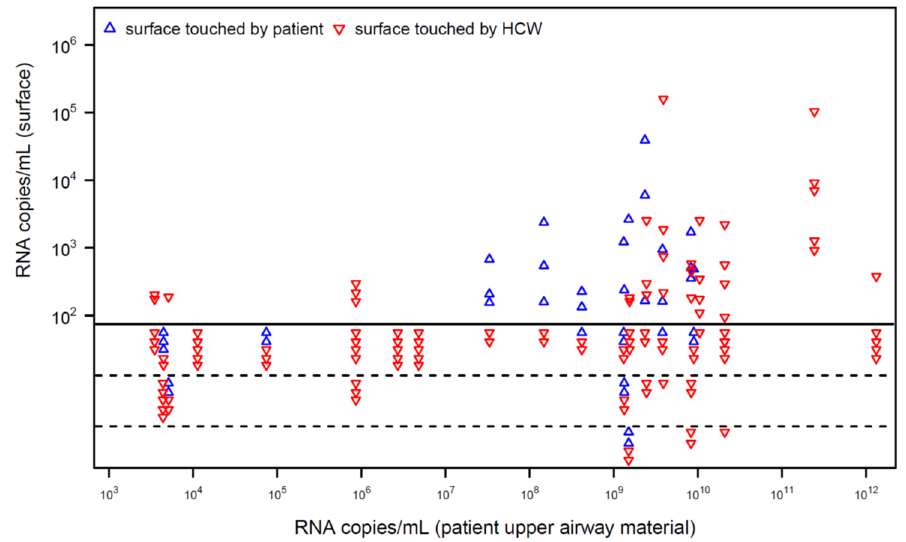
Figure 1. Viral RNA in the immediate patient environment. The number of detectable copies of viral RNA is shown for surfaces in the immediate patient environment. The viral burden on near-patient surfaces in intensive care units was examined on surfaces touched by spontaneously breathing patients (blue triangles) and surfaces used by health care workers (HCW; red triangles) and correlated with the RNA load detectable in the upper airways of the respective patients (nasopharyngeal swab or tracheal secretion) from the same day or with a maximum time interval of one day. Triangles below the solid line represent PCR results below the detection limit. Dashed lines separate the results of different patients with comparable RNA loads in the upper airways.